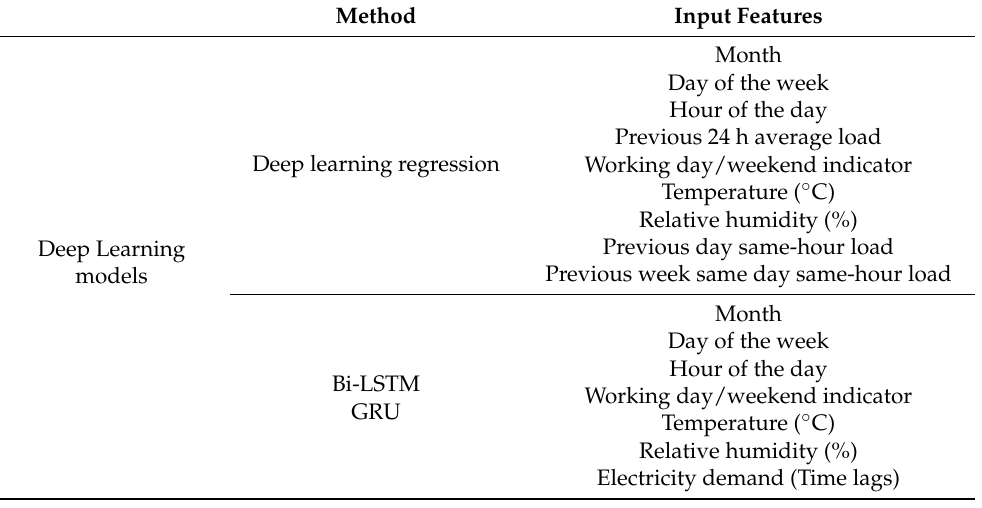
Table 3. Input features used for Models.